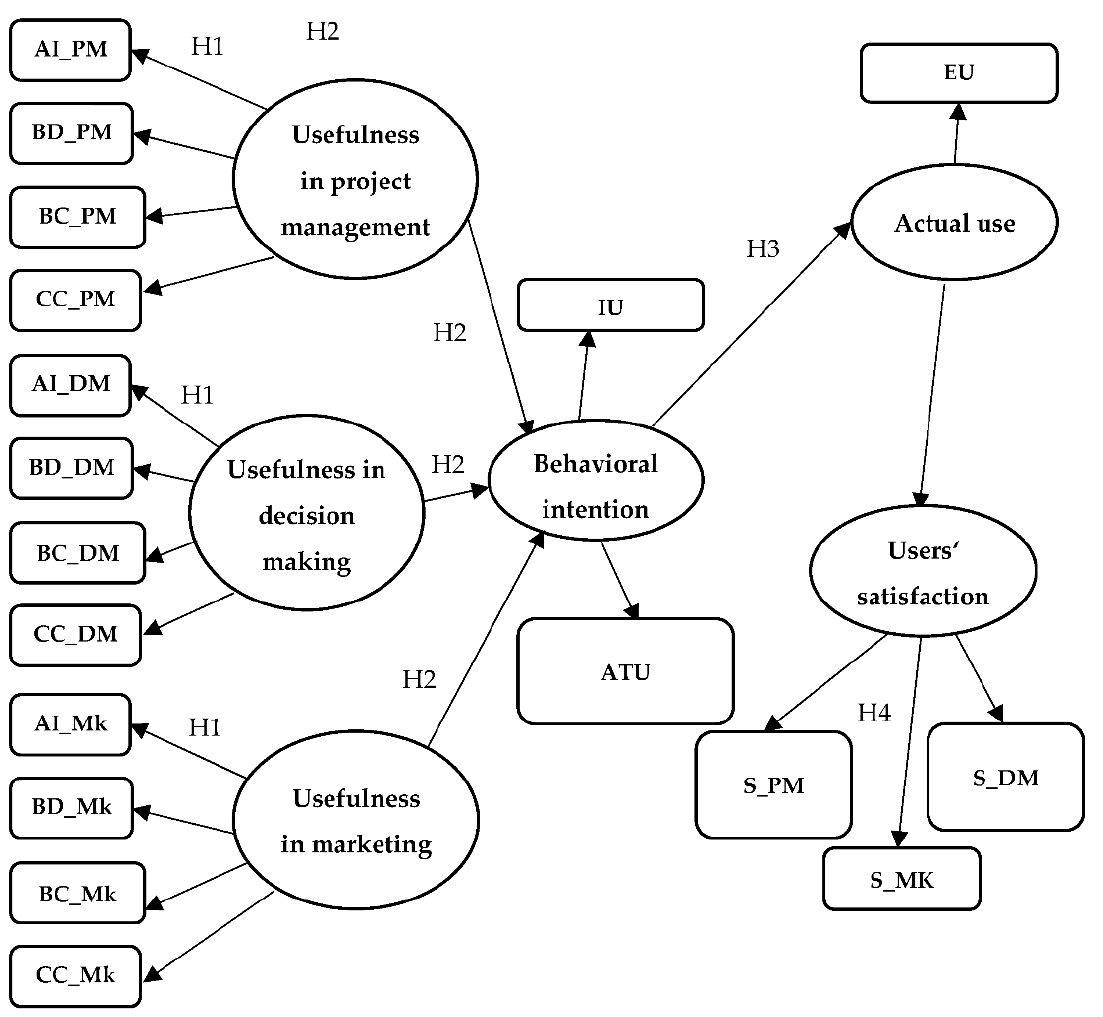
Figure 2. Theoretical PMTU model. Source: own construction based on [3,5,18 – 40,53 – 58].